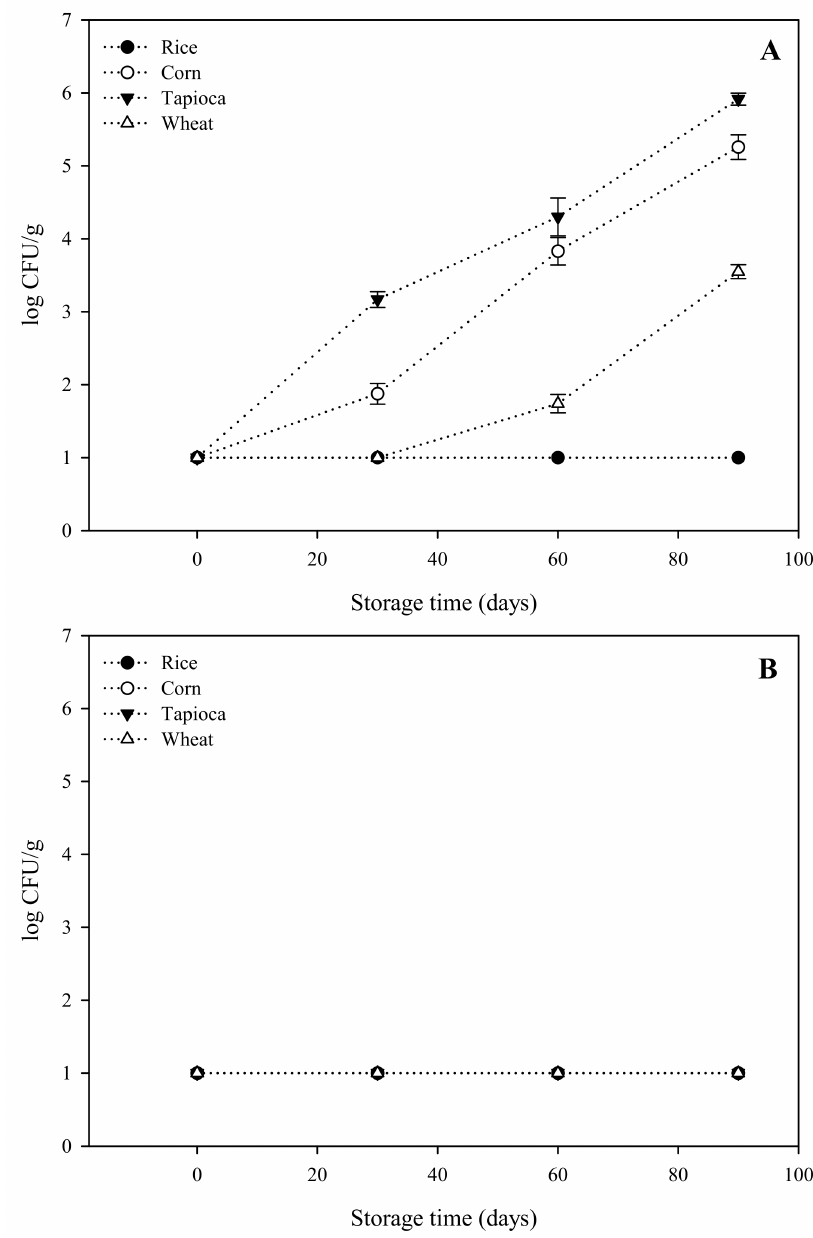
Figure 1. Growth curves of aerobic mesophilic total count ( A ) and yeasts and molds ( B ) of starch- based HPP hydrogels during the storage period. Symbols are means of three measurements ± standard deviations